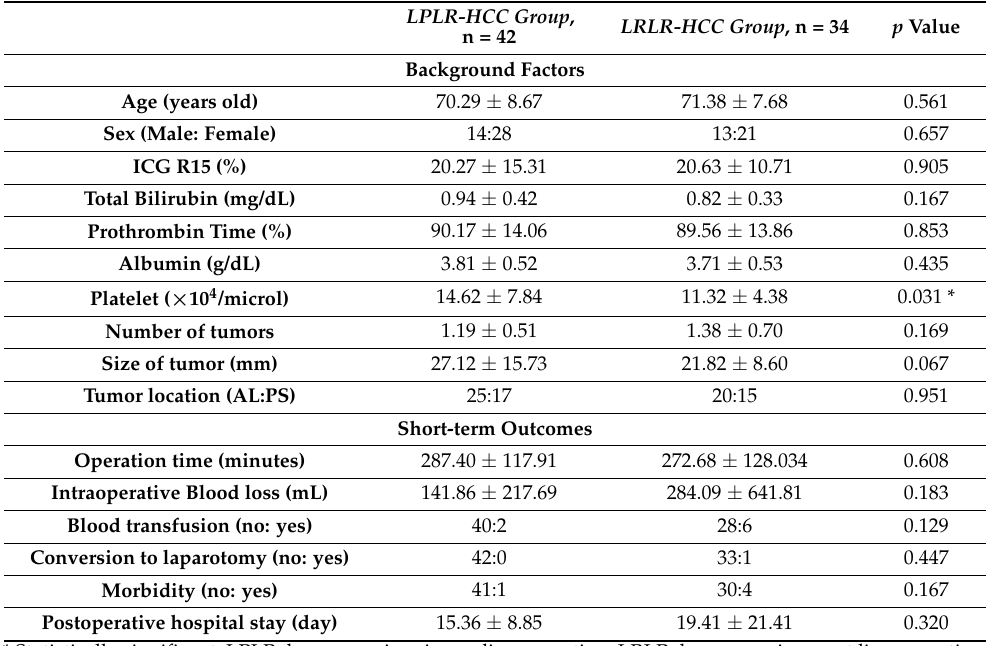
Table 2. Comparison between laparoscopic primary and repeat liver resection for the HCC patients who have undergone segmentectomy or less resection in background factors and postoperative short-term